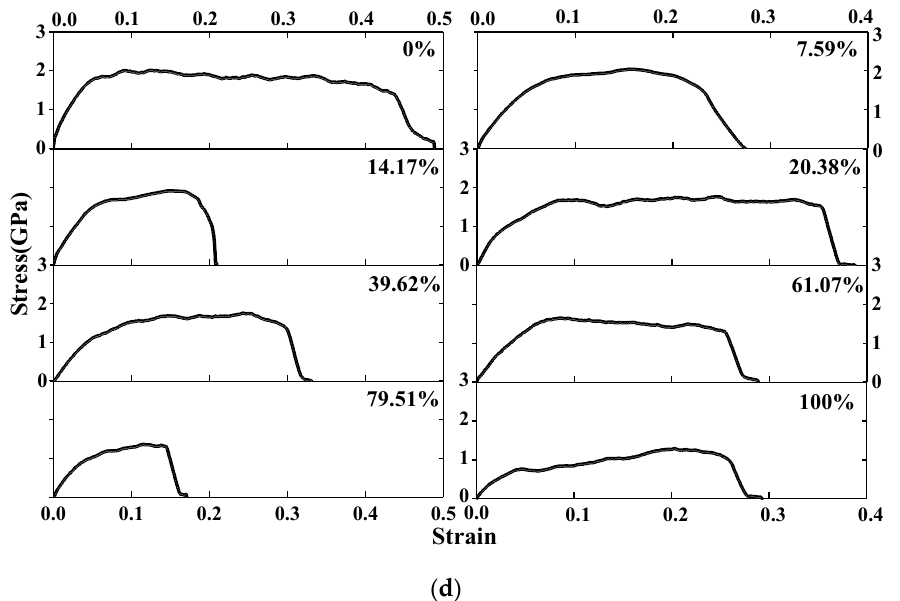
Figure 3. Stress-strain relationship curves of C–S–H with different degrees of saturation under different strain rates. (a) 0.8 ps − 1 ; (b) 0.08 ps − 1 ; (c) 0.008 ps − 1 ; (d) 0.0008 ps − 1.